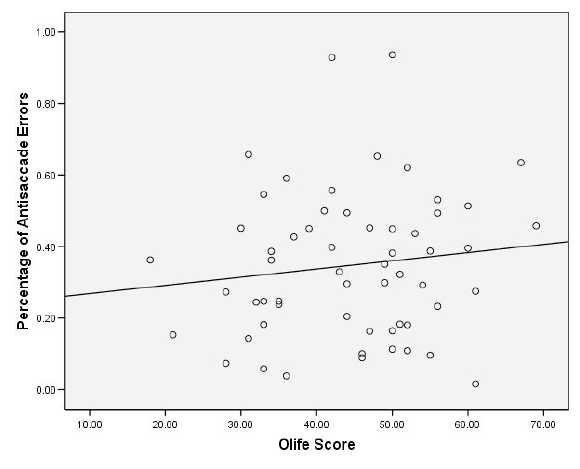
Figure 4. Correlation of Olife scores and antisaccade errors.